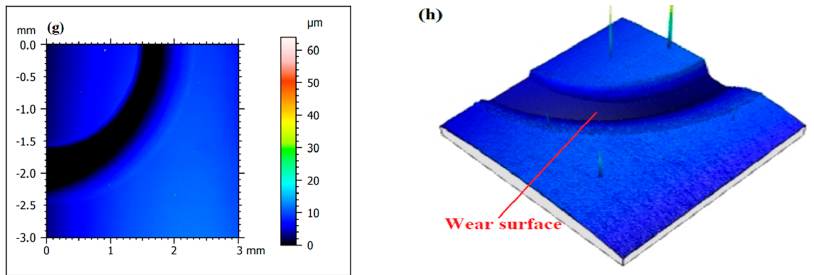
Figure 11. Profiles of worn surfaces of different cladding layers. ( a , b ) Fe316L; ( c , d )Co-Cr; ( e , f ) Co-Cr-20%WC; ( g , h ) Co-Cr-40%WC.